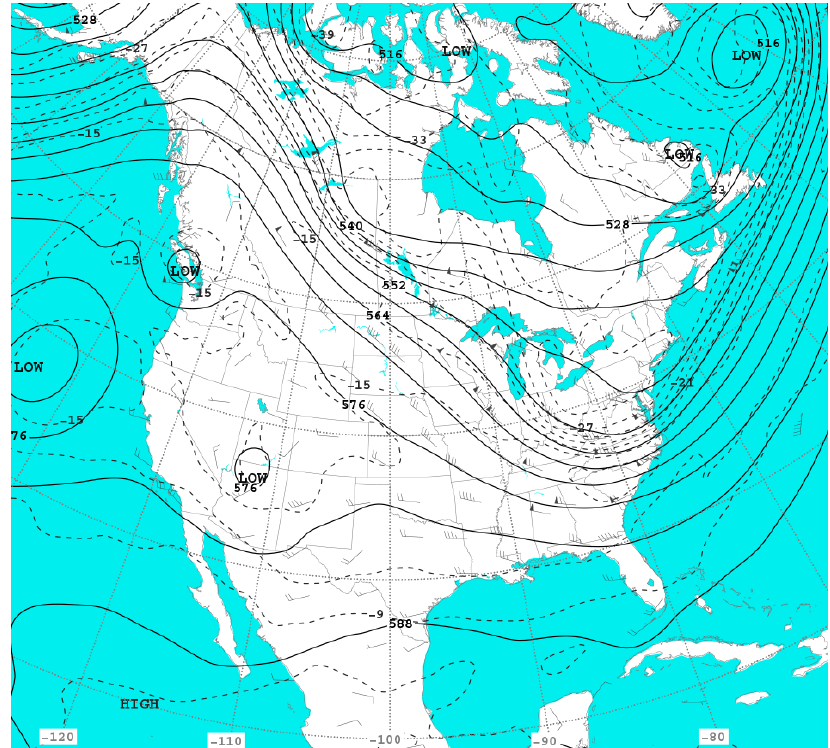
Figure 8. A 500 millibar (mb) height contour national map for 11:00UTC on 25 October 2013, for the meteorological events that surrounded the test case is shown. The figure shows height contours (solid lines), temperatures (dashed lines), and winds (arrows). The height contours show the height of the 500mb pressure level in dekameters above sea level; the isotherms, or lines of constant temperature, are shown in degrees Celsius; and the arrows show the wind direction and speed at the 500mb level. (Source: NOAA Daily Weather Map.)